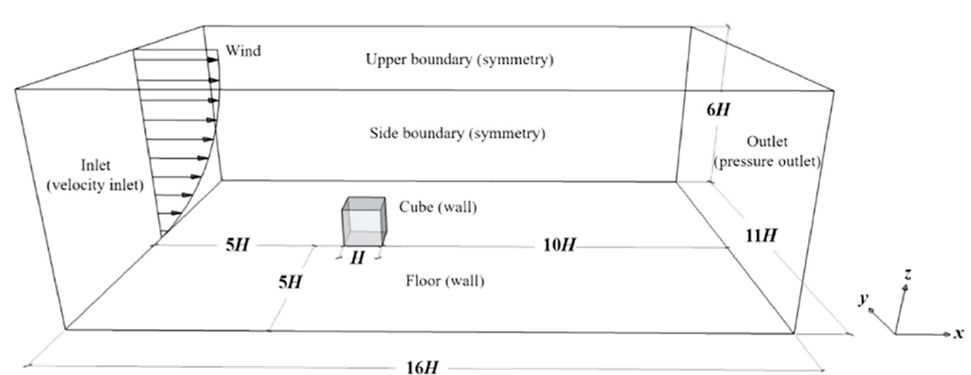
Figure 3. Computational grids: ( a ) coarse mesh, 231,400 hexahedral cells with the minimum size being 0.05 H (y + = 250); ( b ) basic mesh, 789,725 hexahedral cells with the minimum size being 0.04 H (y + = 200); ( c ) fine mesh, 2,264,744 hexahedral cells with the minimum size being 0.015 H (y + = 75). The vertical profiles of the inflow, i.e., the streamwise velocity, the turbulent kinetic energy, and the turbulent dissipation rate, were given according to the experimental re- sults. The vertical velocity profile followed a power law with the power law exponent α = 0.23. The turbulent kinetic energy was calculated based on the velocity and turbulent intensity. For the ground surface, the standard wall function was adopted. The realizable k - ε model was selected to simulate the turbulent structure. The advection terms were discretized using a second-order upwind scheme. The semi-implicit method for the pressure-linked equation (SIMPLE) algorithm was used for the pressure–velocity cou- pling. The Green–Gauss cell-based scheme was used for gradient discretization. The RMS residual equaling to 10 − 7 was taken as the convergence criterion. 3.3. Results and Discussion Figure 4 gives a comparison of the streamwise velocity for the three meshes at the center vertical section. No deviation is found among the three meshes except for the lower part of the line at x / H = − 0.5, however, the deviation is quite small. Figure 5 shows the streamlines at the top of the cube for the three meshes. For the coarse mesh, no re- verse flow is reproduced on the building roof, while the reverse flows occur on the two other meshes at x / H ≈ − 0.25. Figure 6 gives a comparison of the streamwise velocity at a horizontal section z / H = 0.15. For all the lines, no difference is observed between the basic and finer meshes, however, the streamwise velocity is overestimated by the coarse mesh. Relatively, the basic mesh-based realizable k - ε model could well reproduce the flow field.